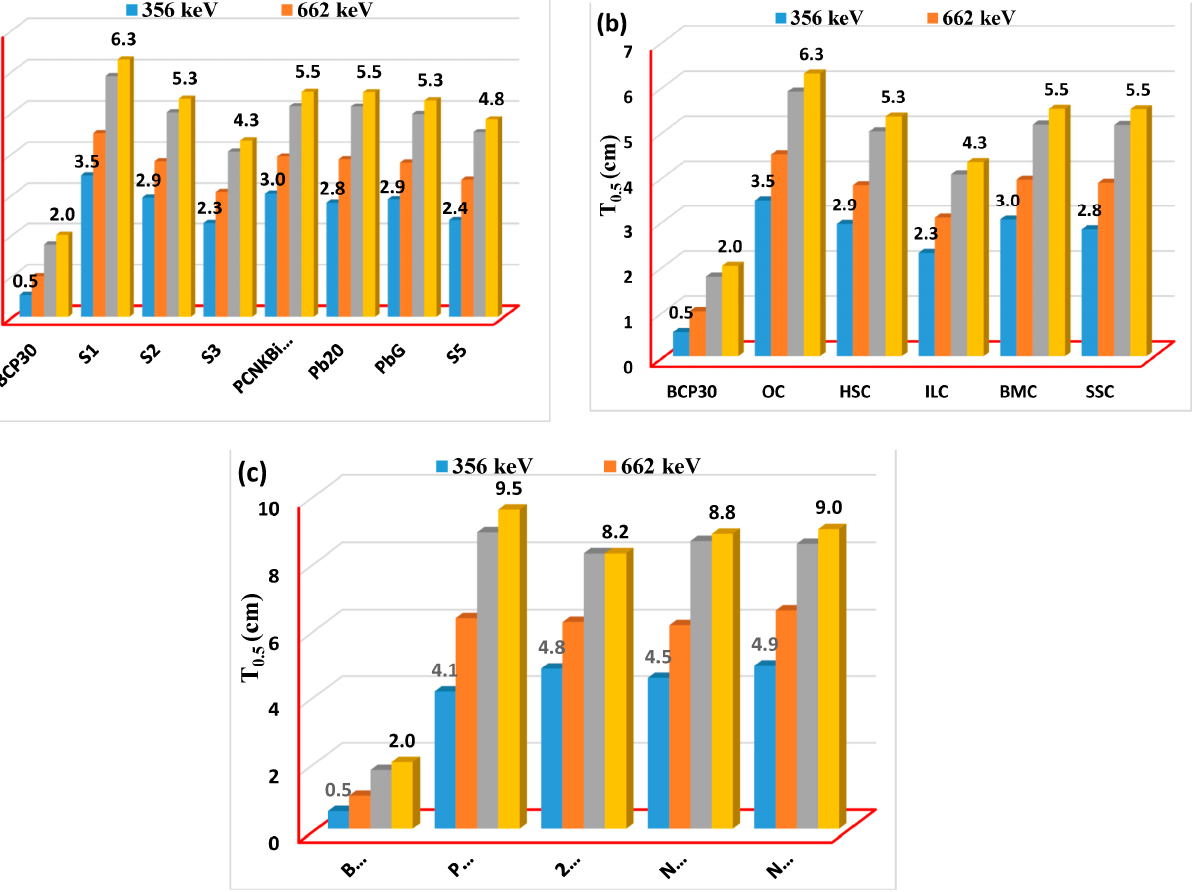
Figure 8. Half-value layer values of a BCP30 glass sample compared to ( a ) glass materials, ( b ) some concrete, and ( c ) polymers at 356, 662, 1173, and 1333 keV.